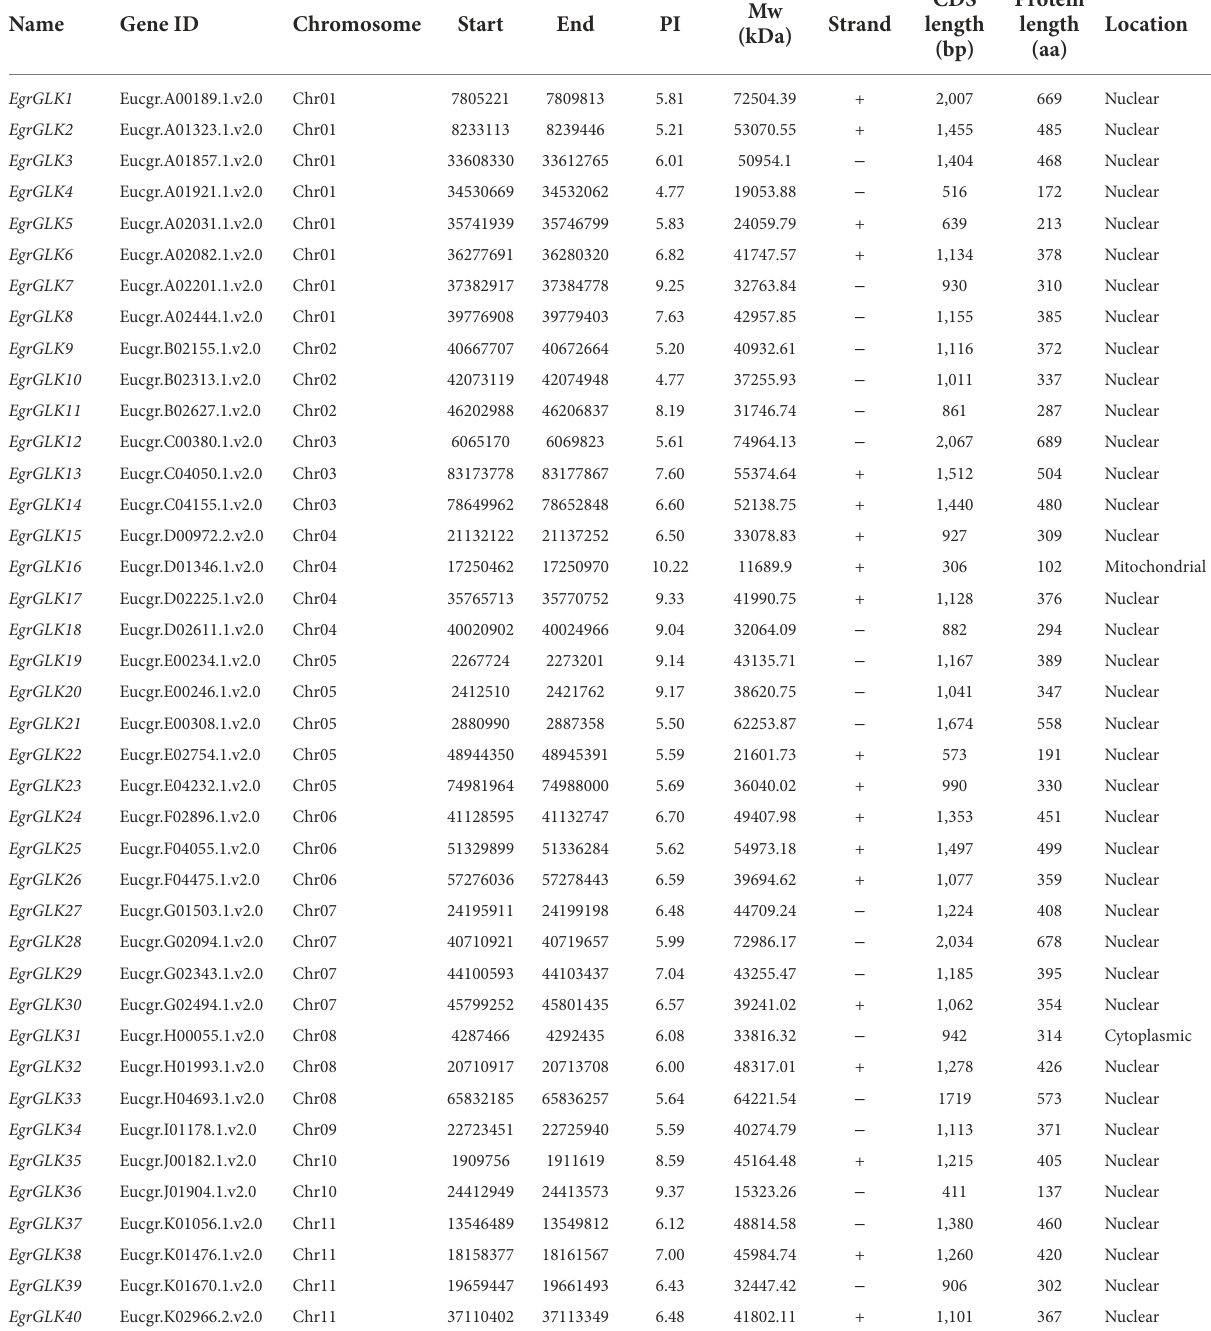
TABLE 1 Physical parameters of GLK transcription factors in Eucalyptus